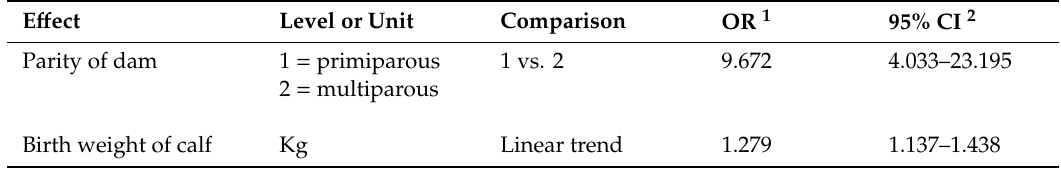
Table 6. Odds ratio estimates for e ff ects in the logistic regression model for dystocia.